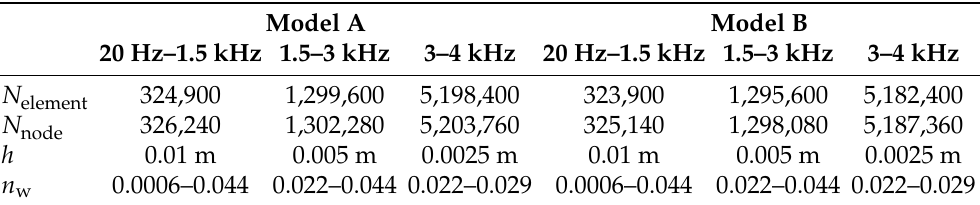
Table 1. Detailed information of the used meshes for the reference solution.